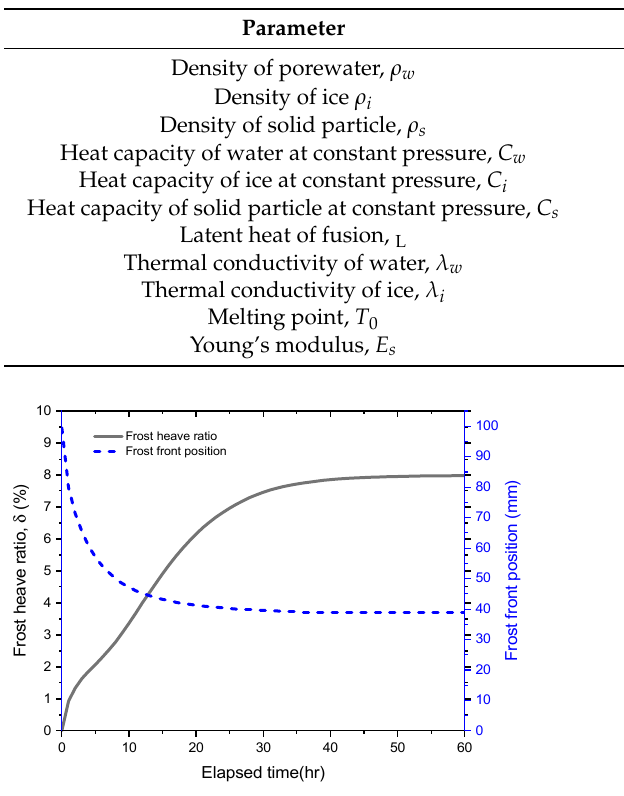
Figure 4. Frost heave ratio and frost front position with time.